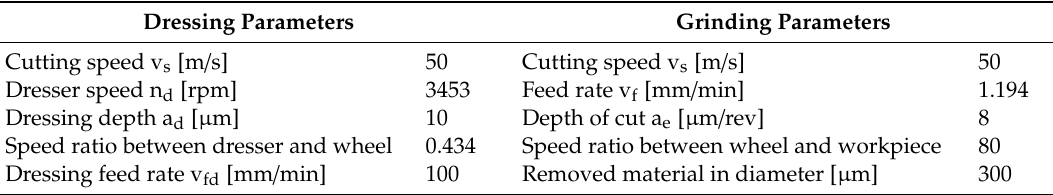
Table 2. Dressing and grinding parameters.